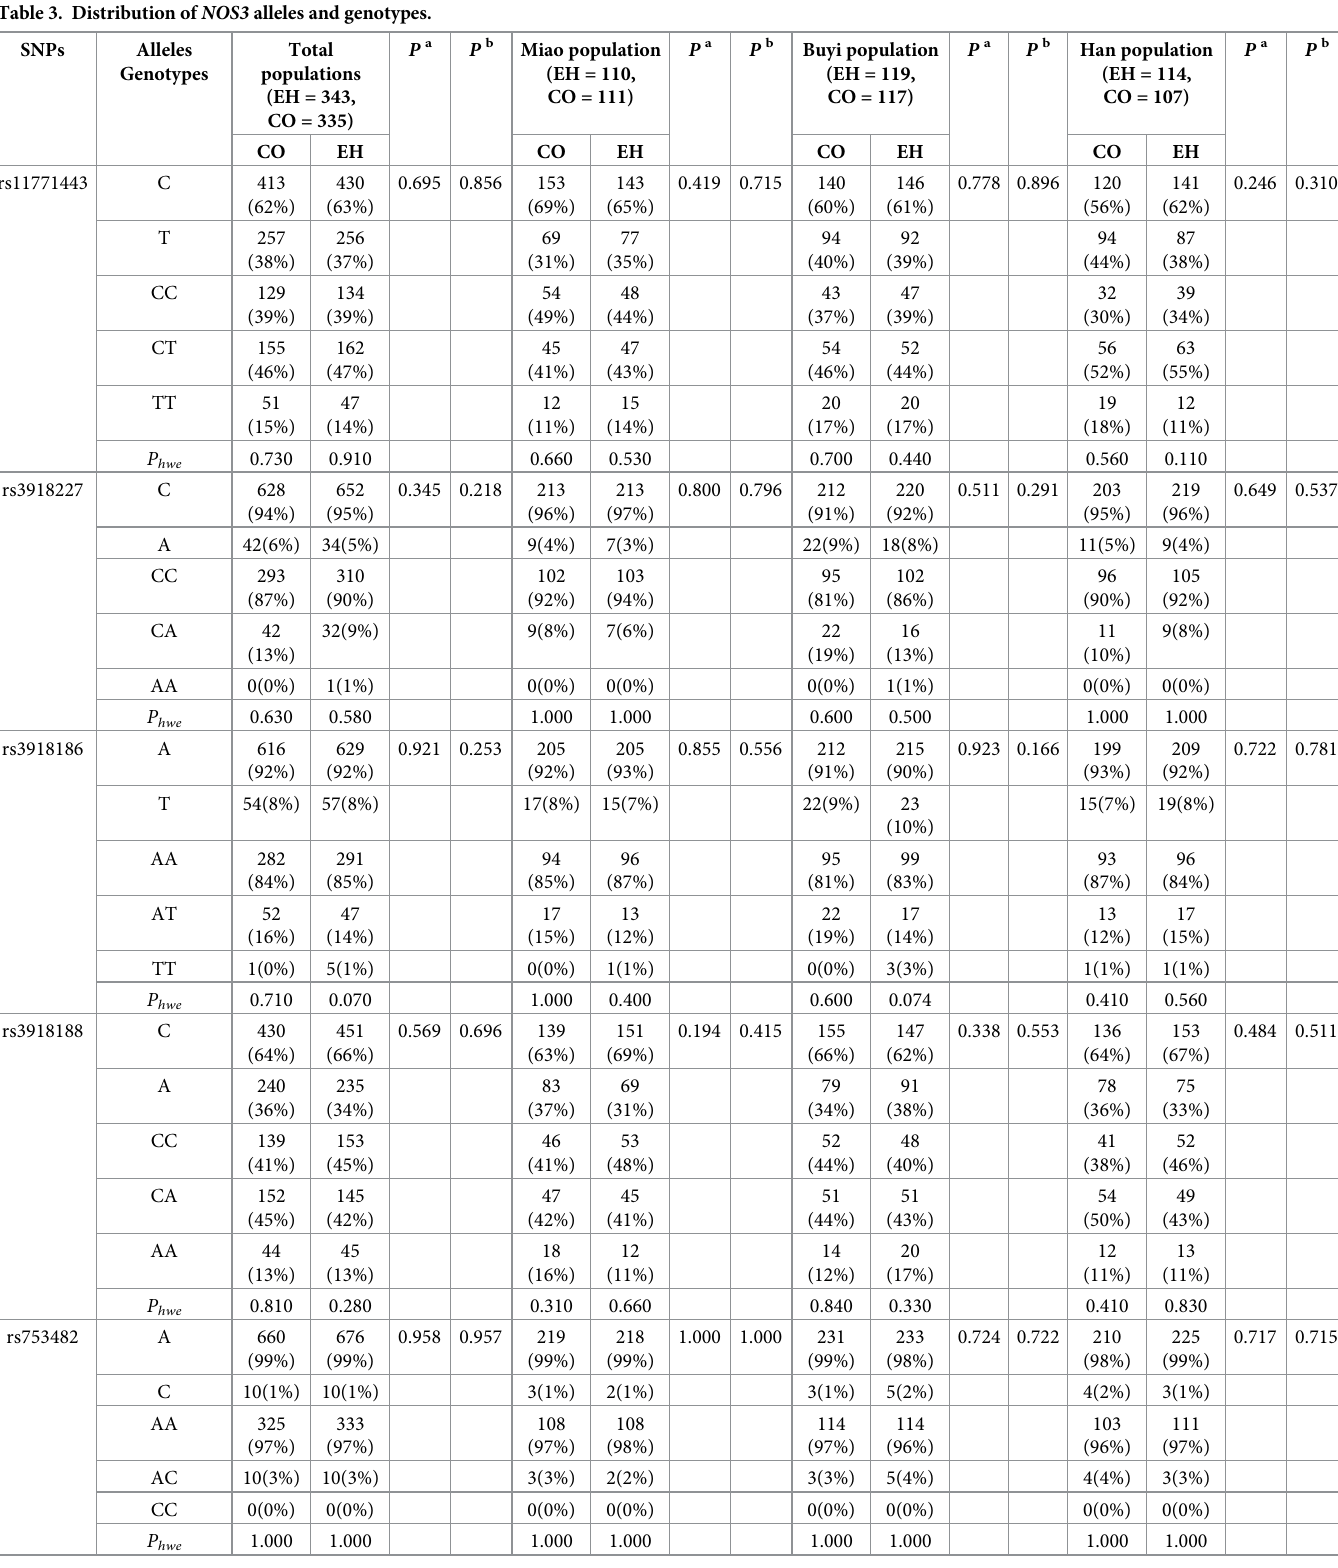
Table 3. Distribution of NOS3 alleles and